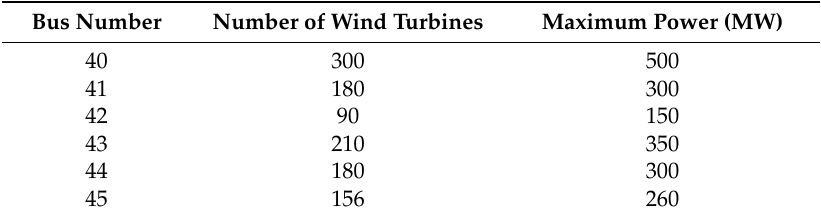
Table 3. Wind turbine information.